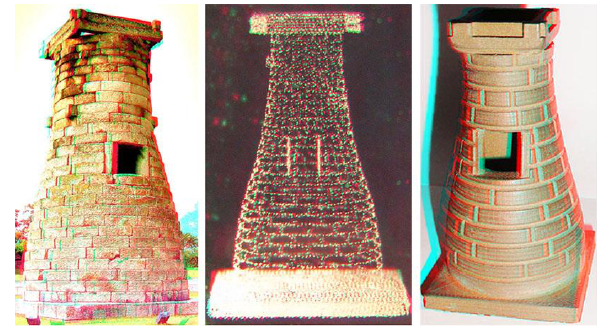
Figure 13. Comparison of a 3D photography of a laser crystal version and a 3D print of the Korean Dabotap pagoda as imaged in figure 12